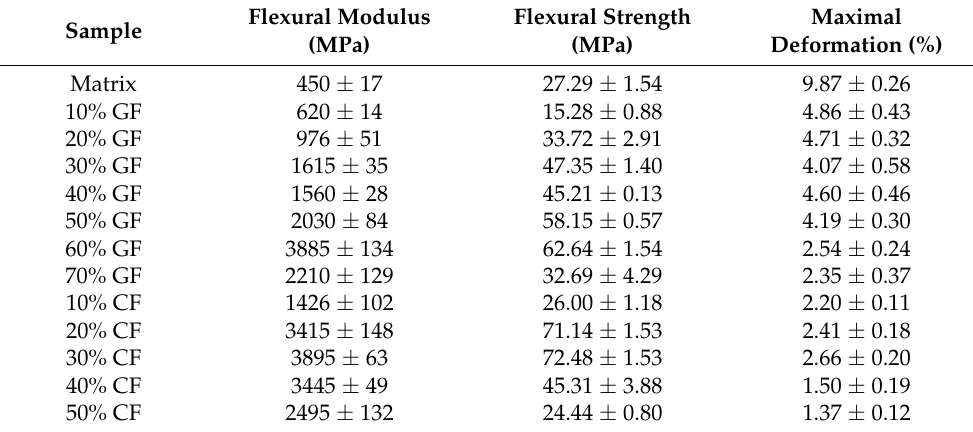
Table 3. Flexural properties of the obtained